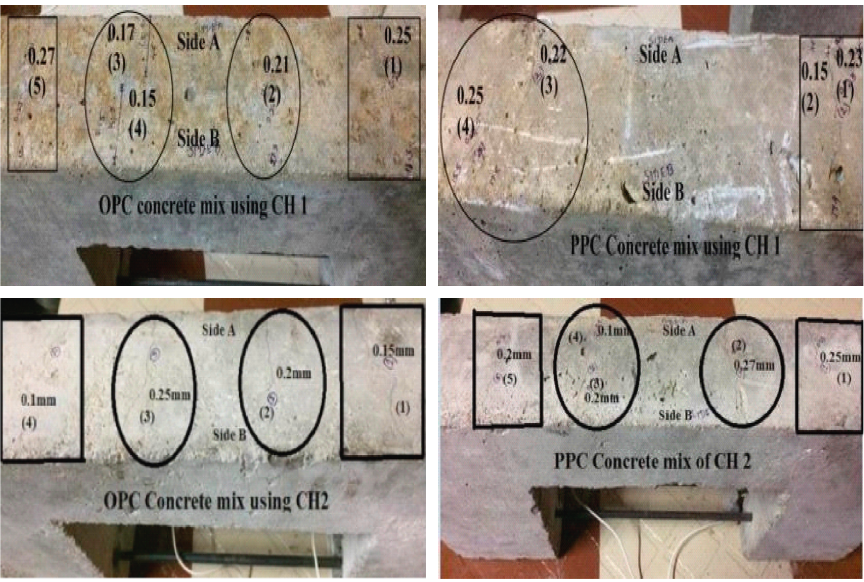
Figure 3: Details of cracks in beams with corrosion inhibitors.